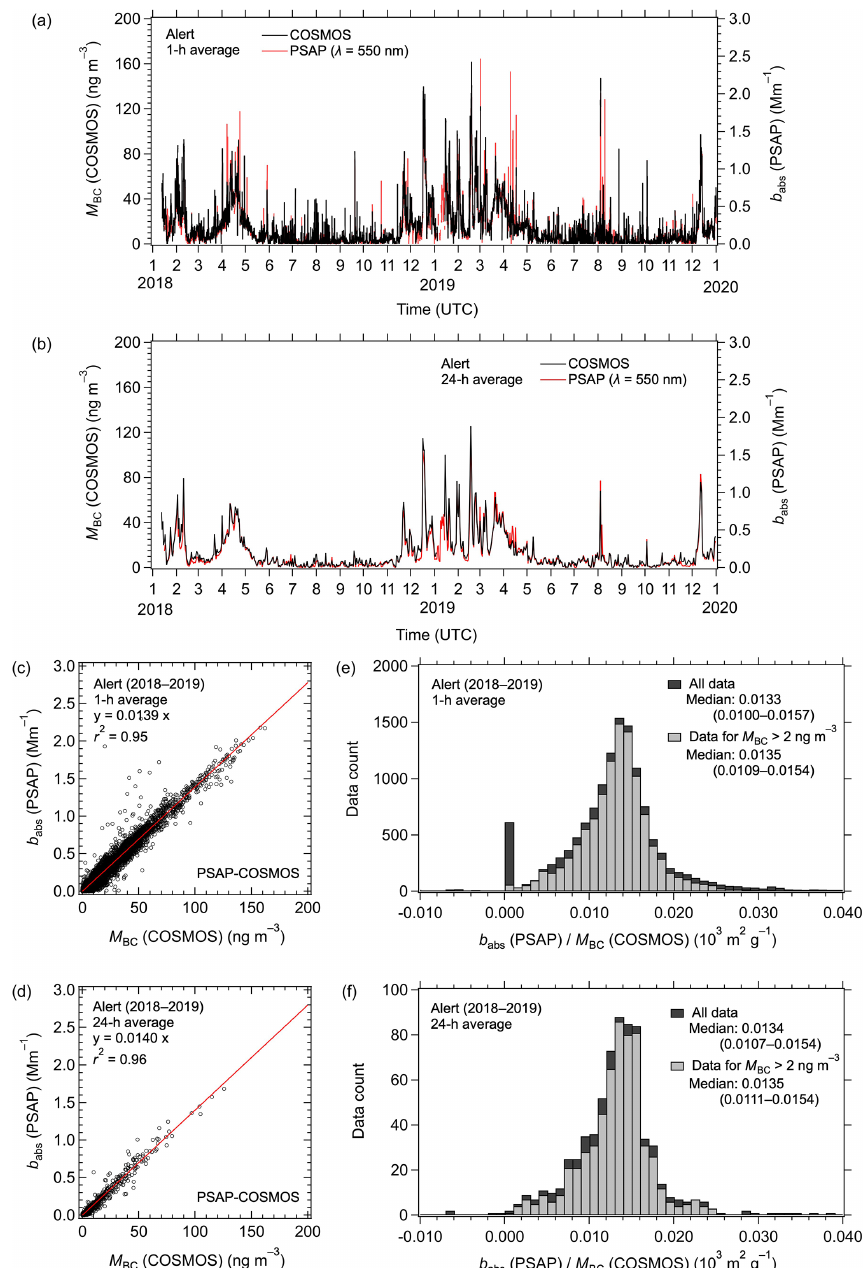
Figure 4. Time series of M BC (COSMOS) and b abs (PSAP; λ = 550nm) from January 2018 to December 2019 at Alert for (a) 1h averaged and (b) 24h averaged data. (c, d) Corresponding correlations of M BC (COSMOS) and b abs (PSAP). The solid red lines are the least-squares regressions forced through the origin. (e, f) Corresponding histograms of b abs (PSAP) /M BC (COSMOS) ratios for all data and data with M BC (COSMOS) > 2ngm − 3 . The interquartile ranges are shown in parentheses.